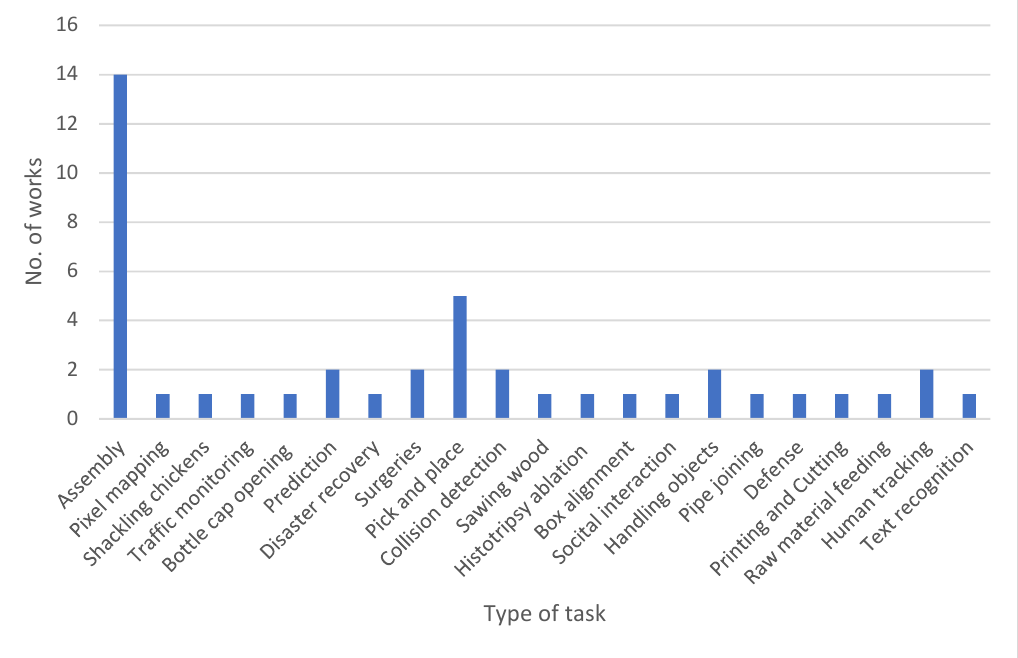
Figure 6. Tasks performed by the robot in collaborative research works.